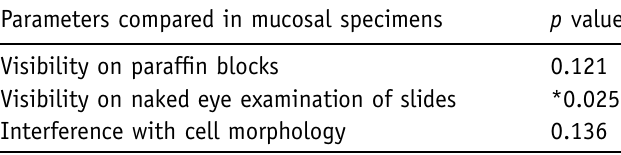
Table V. Visibility of nail enamel and India ink on mucosal specimens.